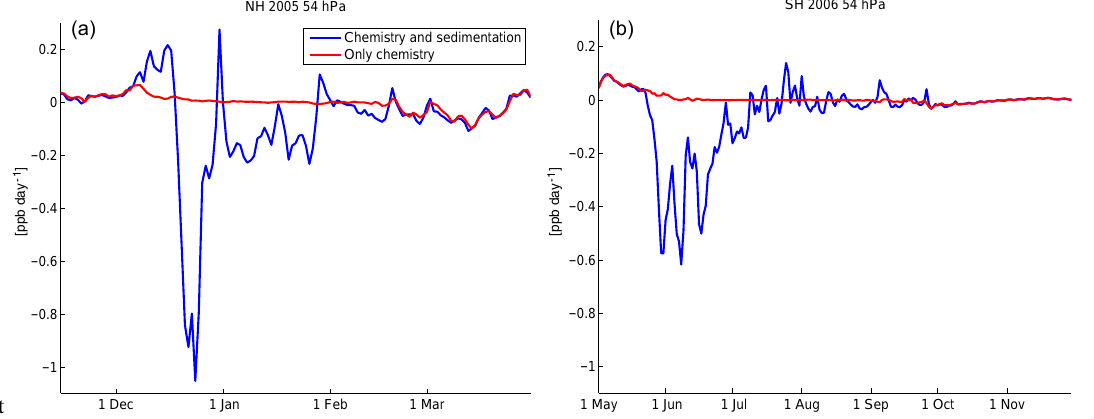
ClONO 2 + HCl → Cl 2 + HNO 3